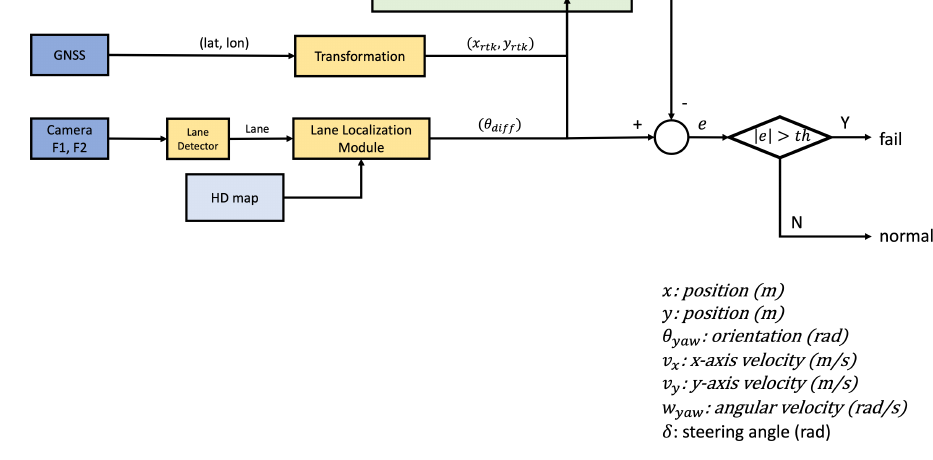
Figure 10. Vehicle pose